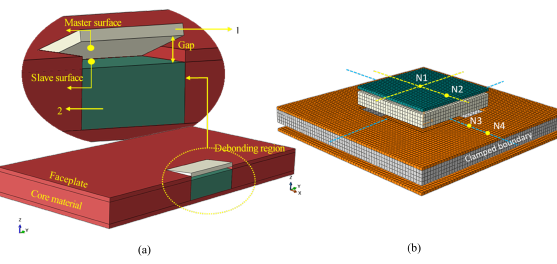
Figure 2: a) Details of intermittent contact modelling in debonded region b) four different measurement points (N) in the upper face- plate.